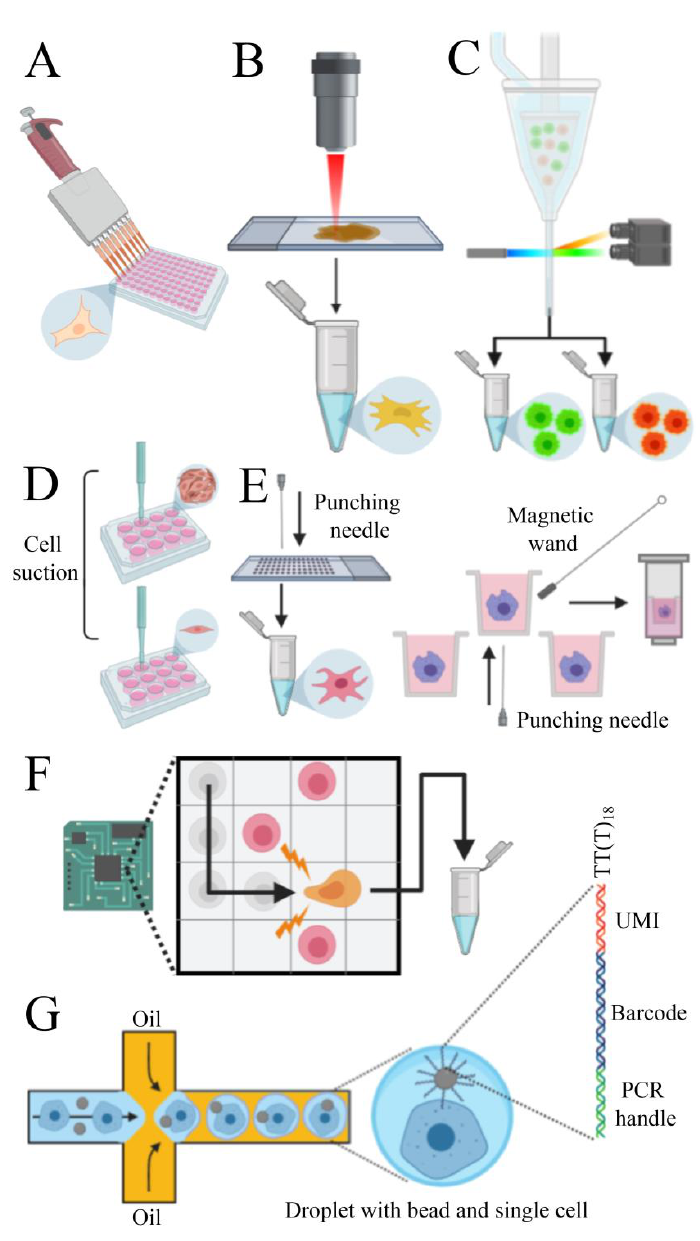
Figure 3. Methods to isolate single cells. ( A ) Micropipette isolation method consists of diluting the sample until obtaining a single cell on each well. ( B ) Laser capture microdissection utilizes a laser linked to a microscope to collect single cells from solid tissues. ( C ) Fluorescent activated cell sorting can sort cells tagged with fluorescent markers. ( D ) Capillary-based technology employs mechanical suction to isolate the cells. ( E ) Punching technologies are based on the principle of capturing cells on microwells and “punch” them on collection vials. ( F ) The dielectrophoresis system uses the electrokinetic properties of cells to move them on a chip. ( G ) Microfluidic platforms can capture single cells and barcoded beads into droplets of water in an oil phase. Each bead contains several primers composed by PCR handles, cell barcodes, and unique molecular identifiers (UMIs) sequences. PCR handles are common in all beads and allows PCR amplification after cDNA synthesis. Cell barcode sequences, identical across all the primers of the same microparticle but di ff erent from those on di ff erent beads, allow recovery of the cells’ origin. UMIs, di ff erent on each primer, allow mRNA transcripts to be digitally counted and to identify PCR duplicates. An oligod(T) sequence is present at the end of all primers for capturing polyadenylated RNAs and priming reverse